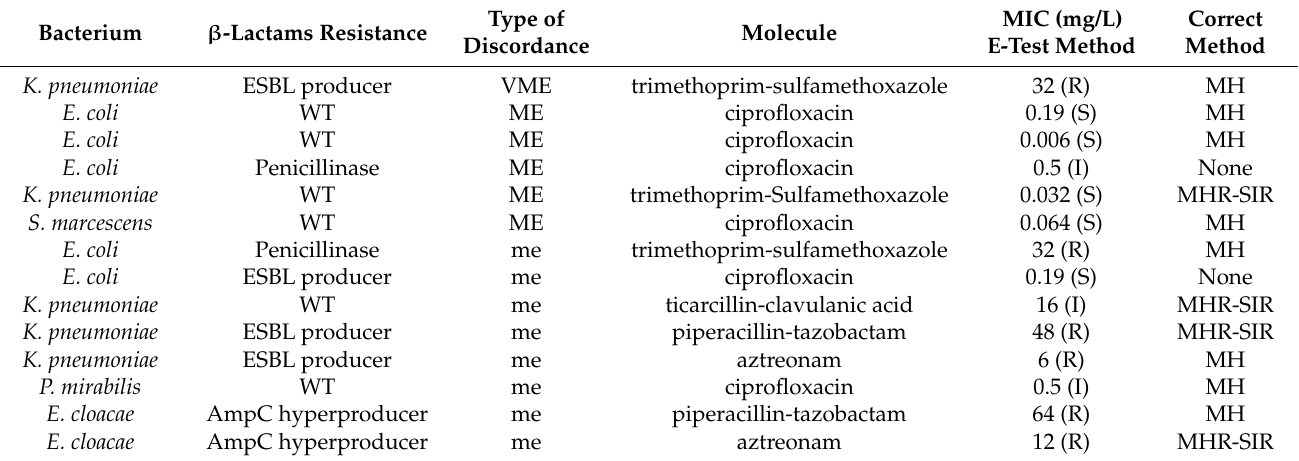
Table 3. Antibiotic categorisation discordances between ASTs performed on MHR-SIR and on MH agar from 110 Enterobacterales -positive blood culture